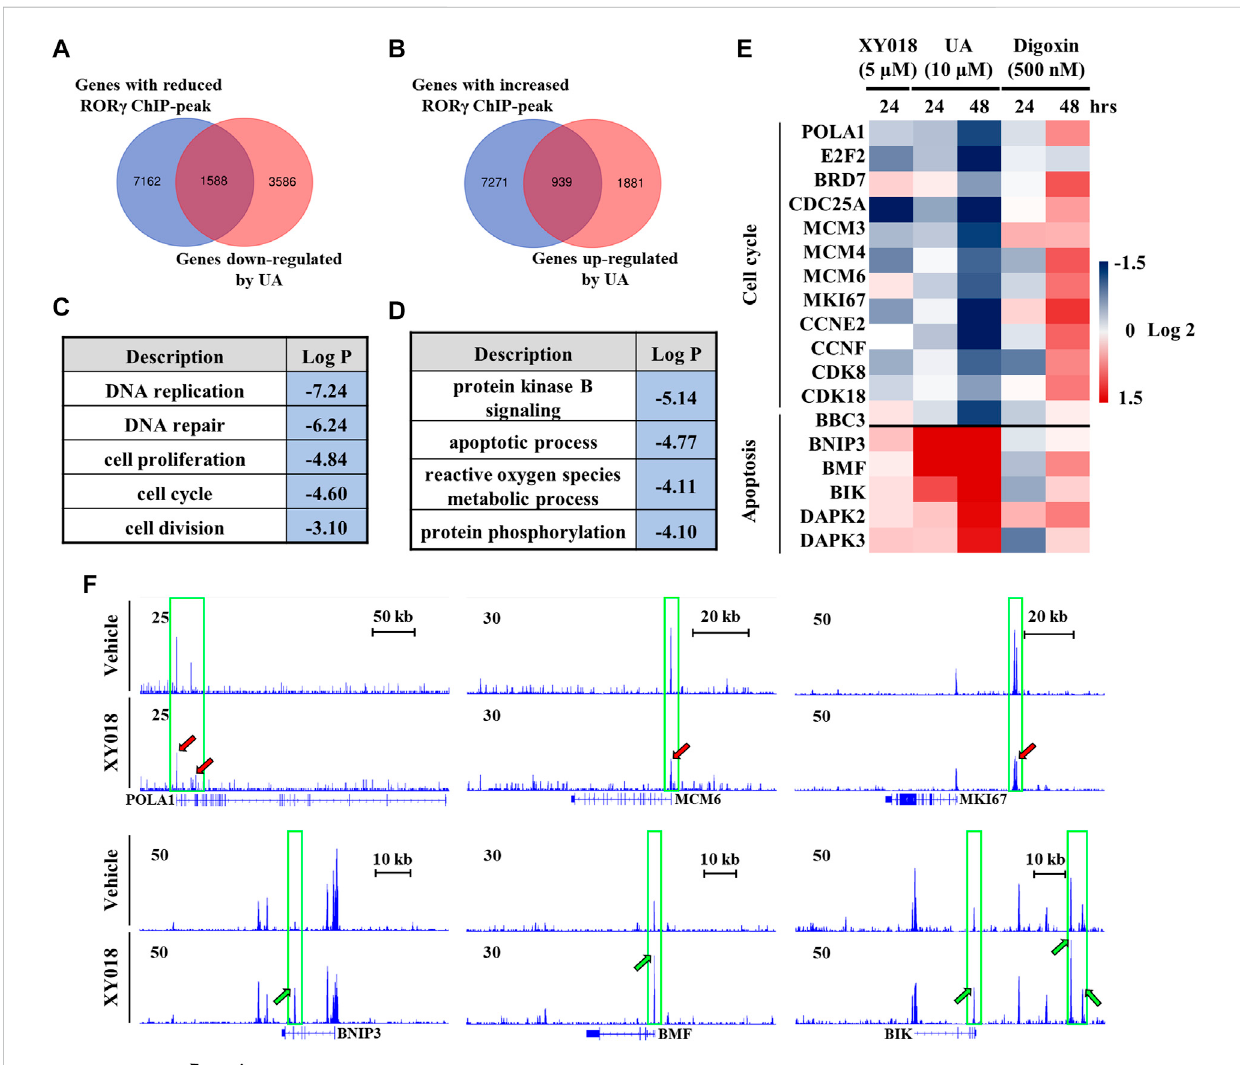
FIGURE 5 Expression of ROR γ -controlled cell cycle and apoptosis genes was altered by UA but not digoxin in TNBC cells. ( A, B) Venn diagram of number of genes with altered ROR γ ChIP-peaks overlapped with genes altered by UA treatment. ( C, D) Gene ontology analysis of genes with both reduced (C) or increased (D) expression and ROR γ ChIP-peaks as shown in ( A) or (B, E) . Heat map display of fold changes (in log 2) of ROR γ direct target cell cycle and apoptosis gene mRNA in HCC70 cells analyzed by RNA-seq (UA) or qPCR (XY018 and digoxin) at indicated condition. (F) . ChIP-seq signal visualization of ROR γ at representative cell cycle and apoptosis genes in HCC70 cells treated with 2.5 µM of XY018 or vehicle for 24